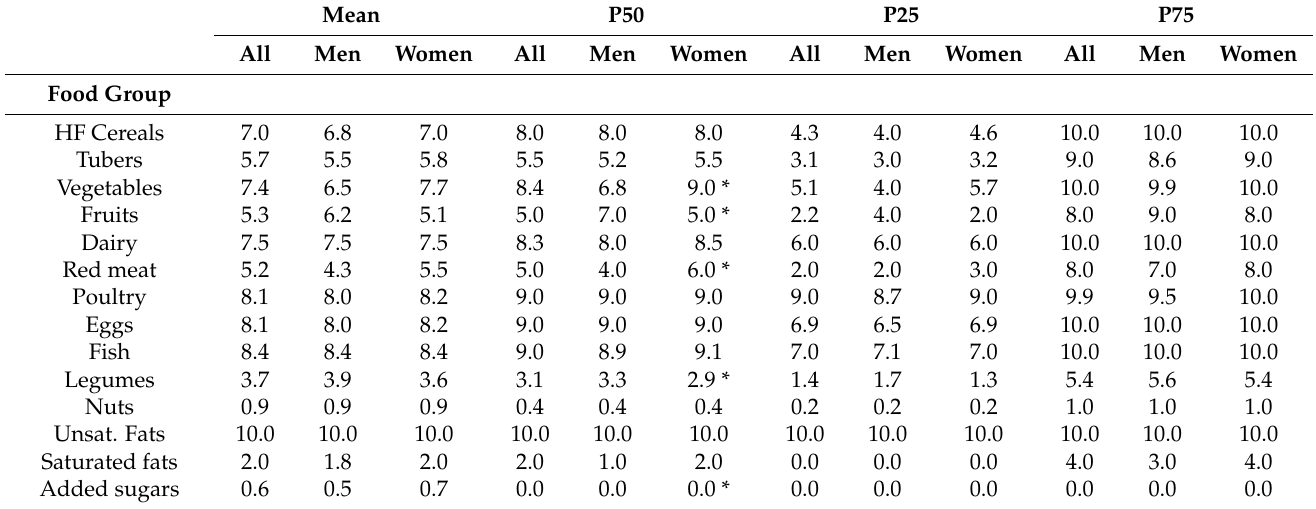
Table 3. SDS distribution by food group of men and women ( n = 1908) 1 .